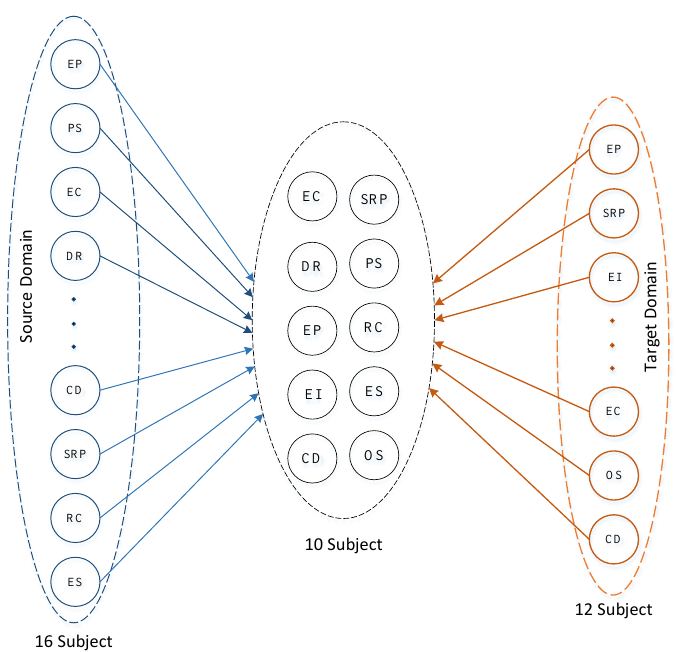
Figure 7. This is the subject classification of the source domain and target domain T1 time slice data: The T1 time slice of the source domain has 16 subjects; The T1 time slice of the target domain has 12 subjects. There are 10 subjects in the union of the two domains.